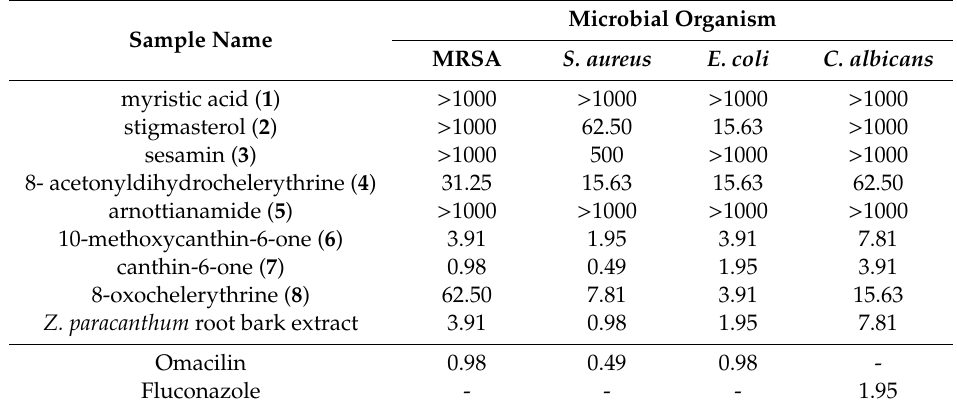
Table 1. Antimicrobial minimal inhibition concentration (MIC) values ( µ g / mL) of the tested